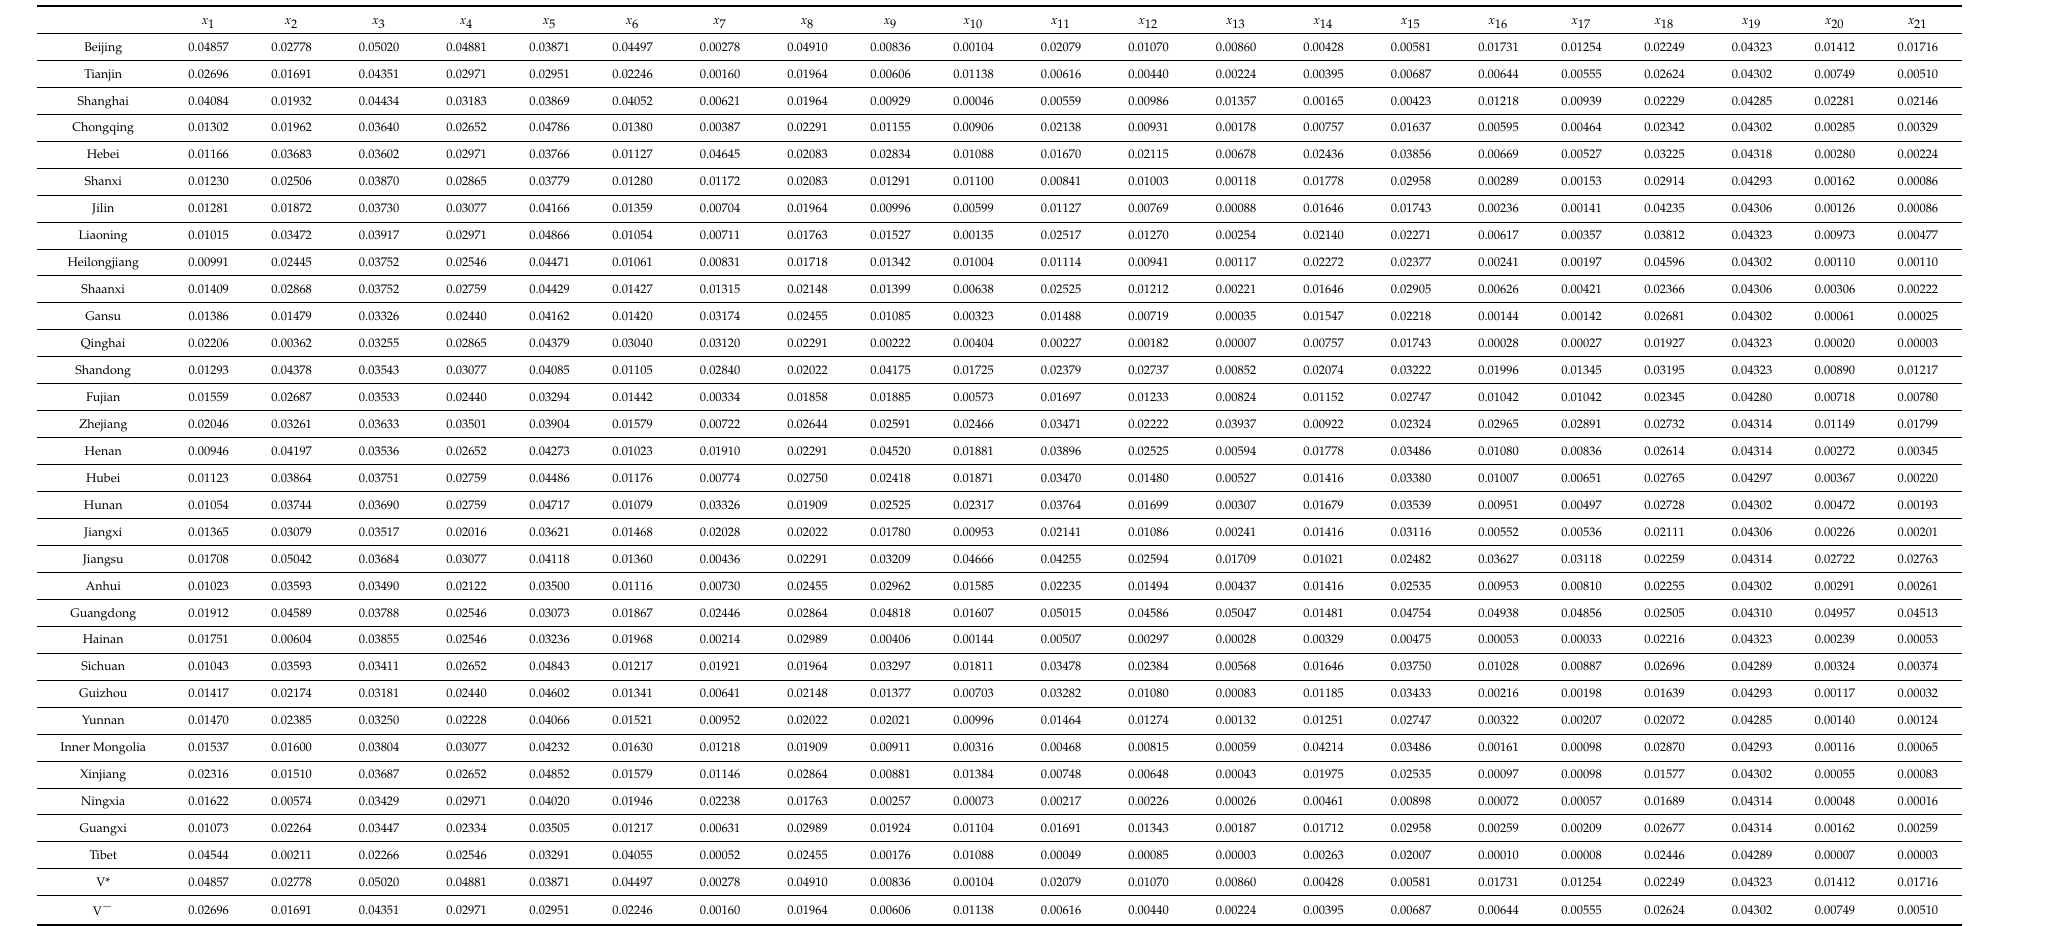
Table A9. The weighted normalized decision